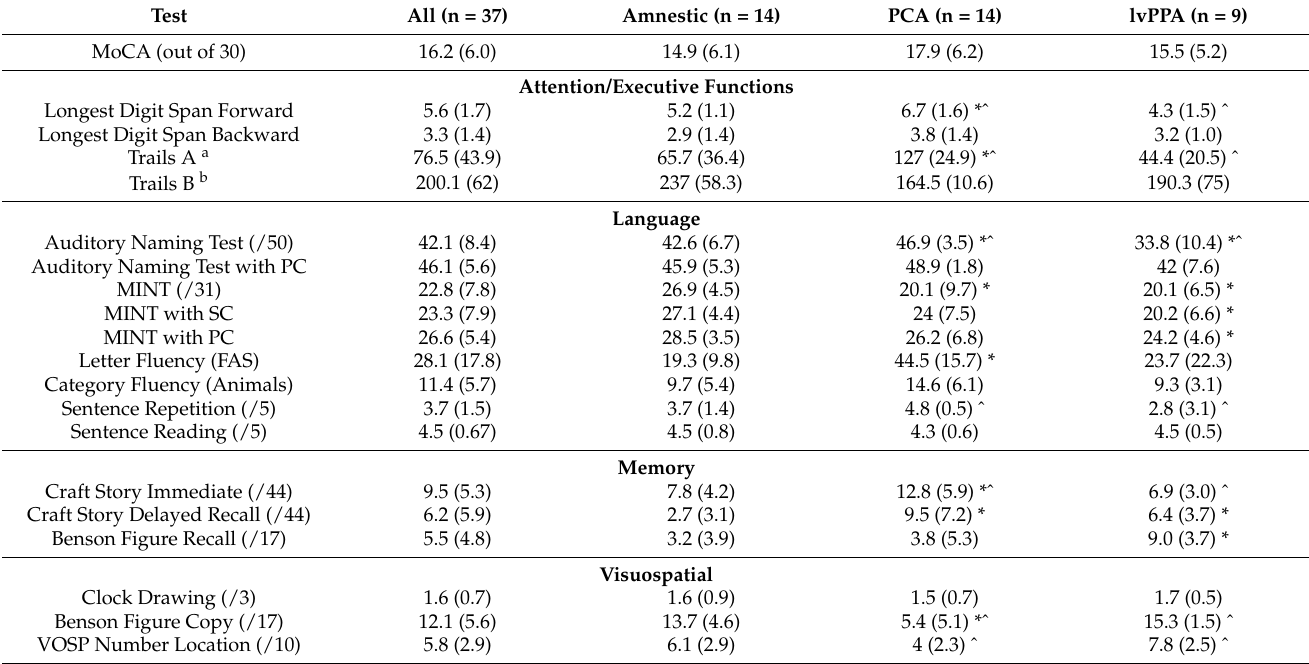
Table 3. Neuropsychological Profiles. Mean (SD) presented for each test